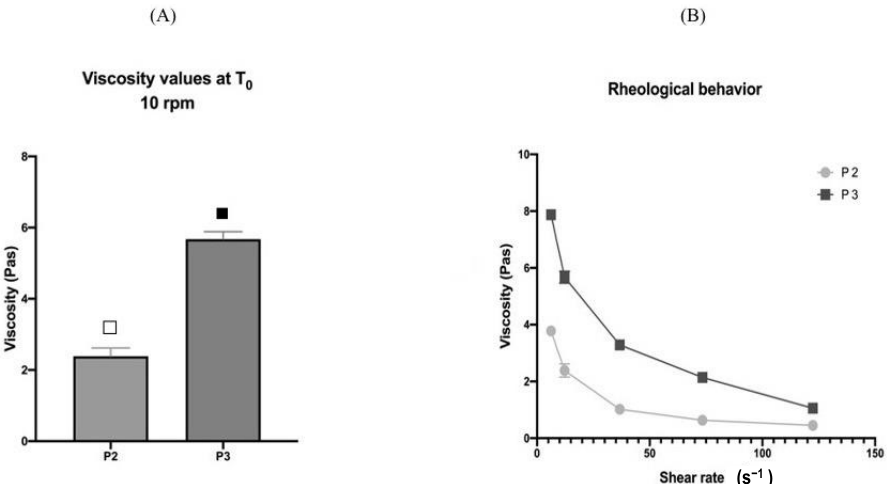
Figure 1. ( A ) Viscosity values at T 0 with 10 rpm applied. ( B ) Rheological behavior at different shear rates applied. Values are expressed as the mean ( ± SD) of sample replicates ( n = 3). Different symbols indicate the differences among the viscosity values on the two products ( p ≤